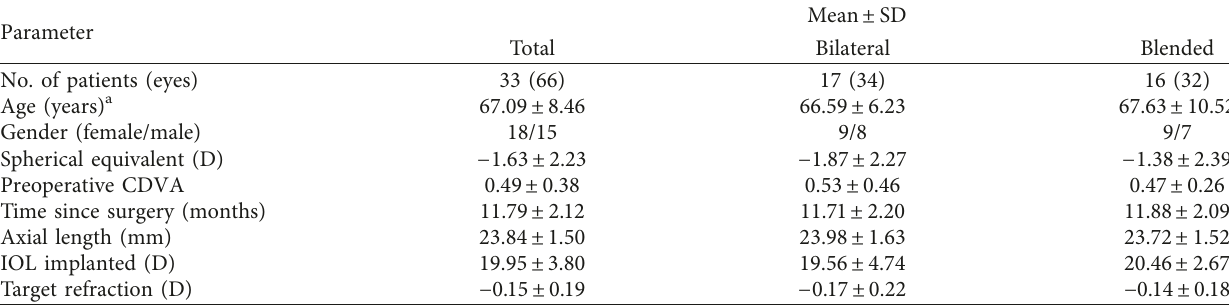
Table 1: Patient characteristics of the two groups.